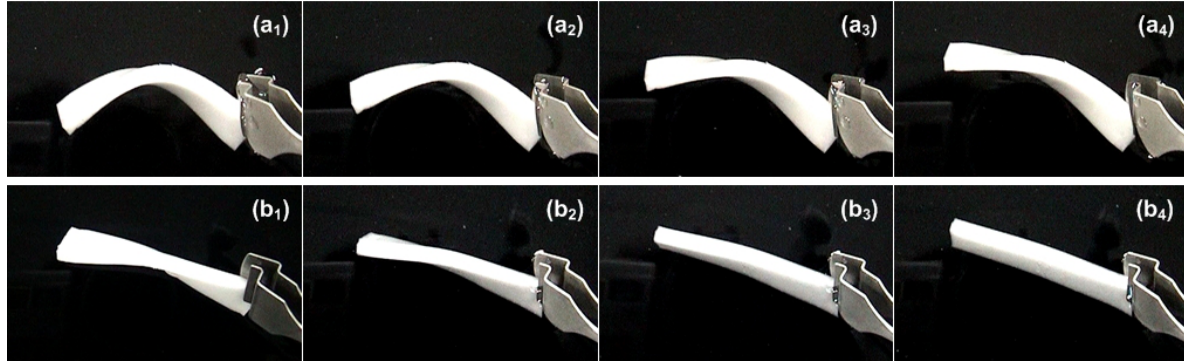
Figure 16. Triple-SME in silicone–paraffin wax (PW) hybrid. ( a ) From twisted-bent shape to twisted shape upon immersion into 45 °C water; and ( b ) from twisted shape to original straight shape upon immersion into 65 °C water